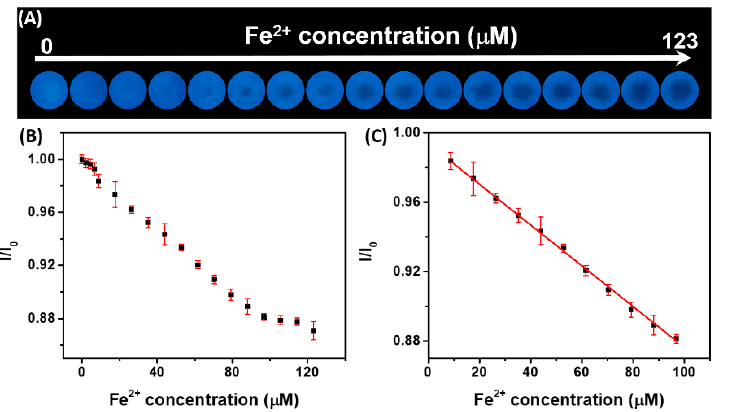
Figure 3. ( A ) Photographic pictures of His-AuNCs-paper-based sensor. The pictures were acquired under UV light excitation, 15 min after drops of solutions containing different concentrations of Fe 2+ (0–123 µ M) was added over the His-AuNCs-paper spots, previously dried for 24 h. ( B ) Plot of the average blue intensity value ratio (I/I 0 ) of His-AuNCs-paper spot versus [Fe 2+ ] in the 0–123 µ M range. ( C ) Plot of the average blue intensity value ratio (I/I 0 ) of His-AuNCs-paper spot versus [Fe 2+ ] along with the linear fitting function used which reveals a linear dynamic range from 9 to 97 µ